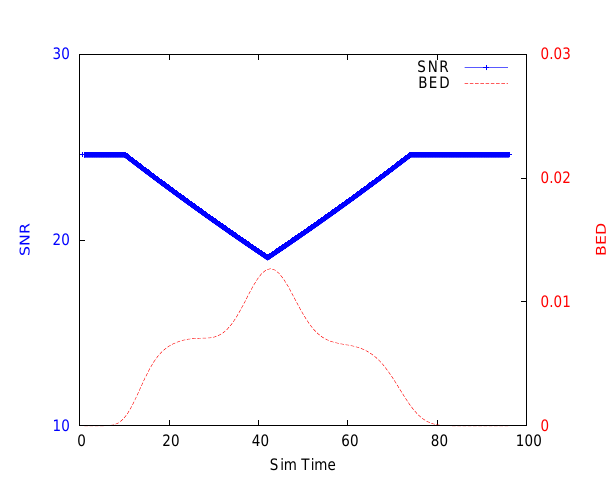
Figure 2. Channel State , BED vs. SNR